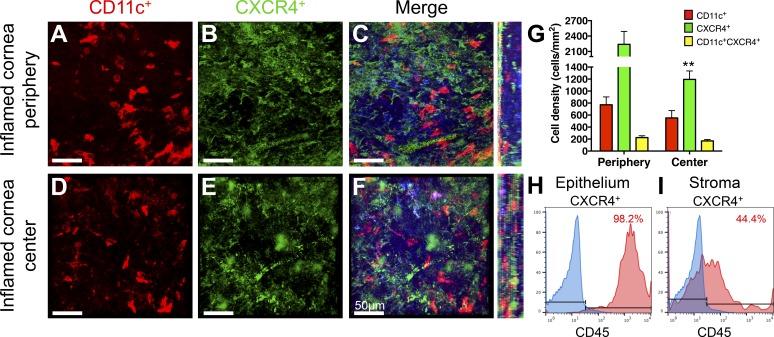
CXCR4 chemokine receptor expression increase in the inflamed murine cornea. Representative confocal micrographs of 7-day suture inflamed BALB/c corneas show increased CD11c+ cells (red, A, D), CXCR4+ cells (green, B, E), and colocalization (yellow, C, F) throughout the corneal stroma of the peripheral (A–C) and central corneas (D–F). Orthogonal views highlight distribution throughout each corneal area. Cell density quantification of CD11c+ and CXCR4+ cells in peripheral and central corneal stroma (cells/mm2) highlights populations of CXCR4+ cDCs to be present following inflammation: significance for cell densities between central and peripheral cornea is denoted by asterisks (G). Representative histograms of flow cytometry analysis of relative CXCR4 expression within CD45+ leukocytes in the inflamed corneal epithelium (H) and stroma (I). Data are shown as mean ± SEM. t-test, **P < 0.01. Scale bars denote 50 μm. n = 4.